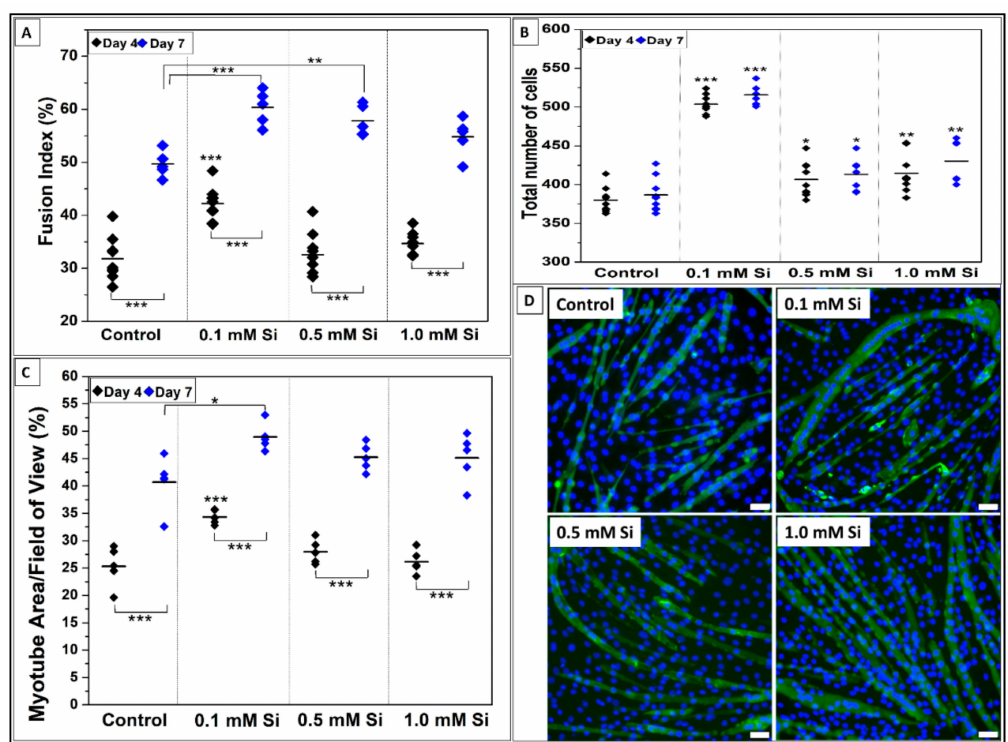
Figure 3. Effect of Si-ions concentration on C2C12 cells after 4 and 7 days of differentiation. ( A ) Fusion index (FI) indicates that 0.1 mM of silicon significantly increases the FI compared to the control after 4 days. Additionally, 0.1, 0.5, and 1.0 mM of silicon significantly increases the FI compared to the control after 7 days (*** p < 0.001, ** p < 0.01, * p < 0.05). FI was significantly increased from day 4 to day 7 for all samples (*** p < 0.001). ( B ) Total number of cells counted from 9 fields of view of DAPI stained nuclei, all used silicon concentration significantly increased the total number of cells at day 4 and 7 compared to the control and 0.1 mM was the optimal concentration with *** p < 0.001 significance. There was no significant difference between the total number of cells from day 4 to 7. ( C ) Area covered by myotubes (%) also indicated that all used silicon concentrations increase the total area of myotubes per field of view compared to the control and 0.1 mM Si showed high significance at day 4 and 7. Also, the myotube area showed a significant increase from day 4 to 7 for all samples and the control. ( D ) represents fluorescence images of DAPI-stained nuclei (blue) and myosin heavy chain antibody (MHC, green)-stained myocytes/myotubes of C2C12 myoblasts on the tissue culture plate (TCP) as a control and the three different Si-ions concentrations (0.1 mM, 0.5 mM, and 1.0 mM) after 4 days of differentiation. Scale bar is 50 µ m and *** p < 0.001, ** p < 0.01, * p <